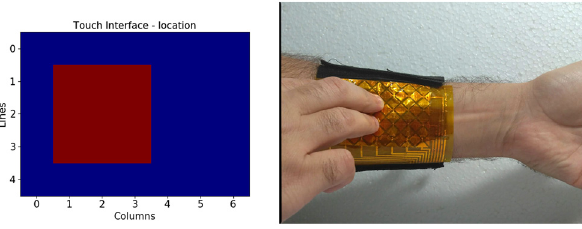
Figure 17: Conversion of the touch detected to electrode activation. The redder color represents the pair of electrodes that should be activated and its